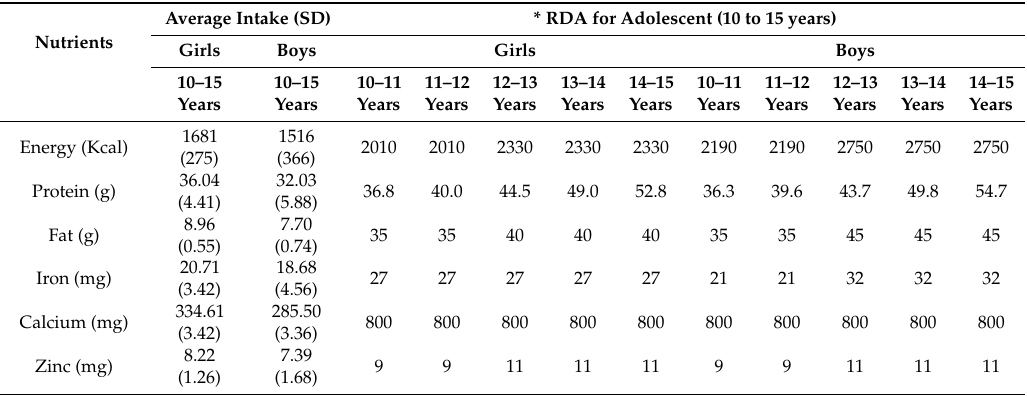
Table 5. Estimated nutrient intake recorded in three-day diet diary compared to the recommended dietary allowance (RDA) for adolescent girls and